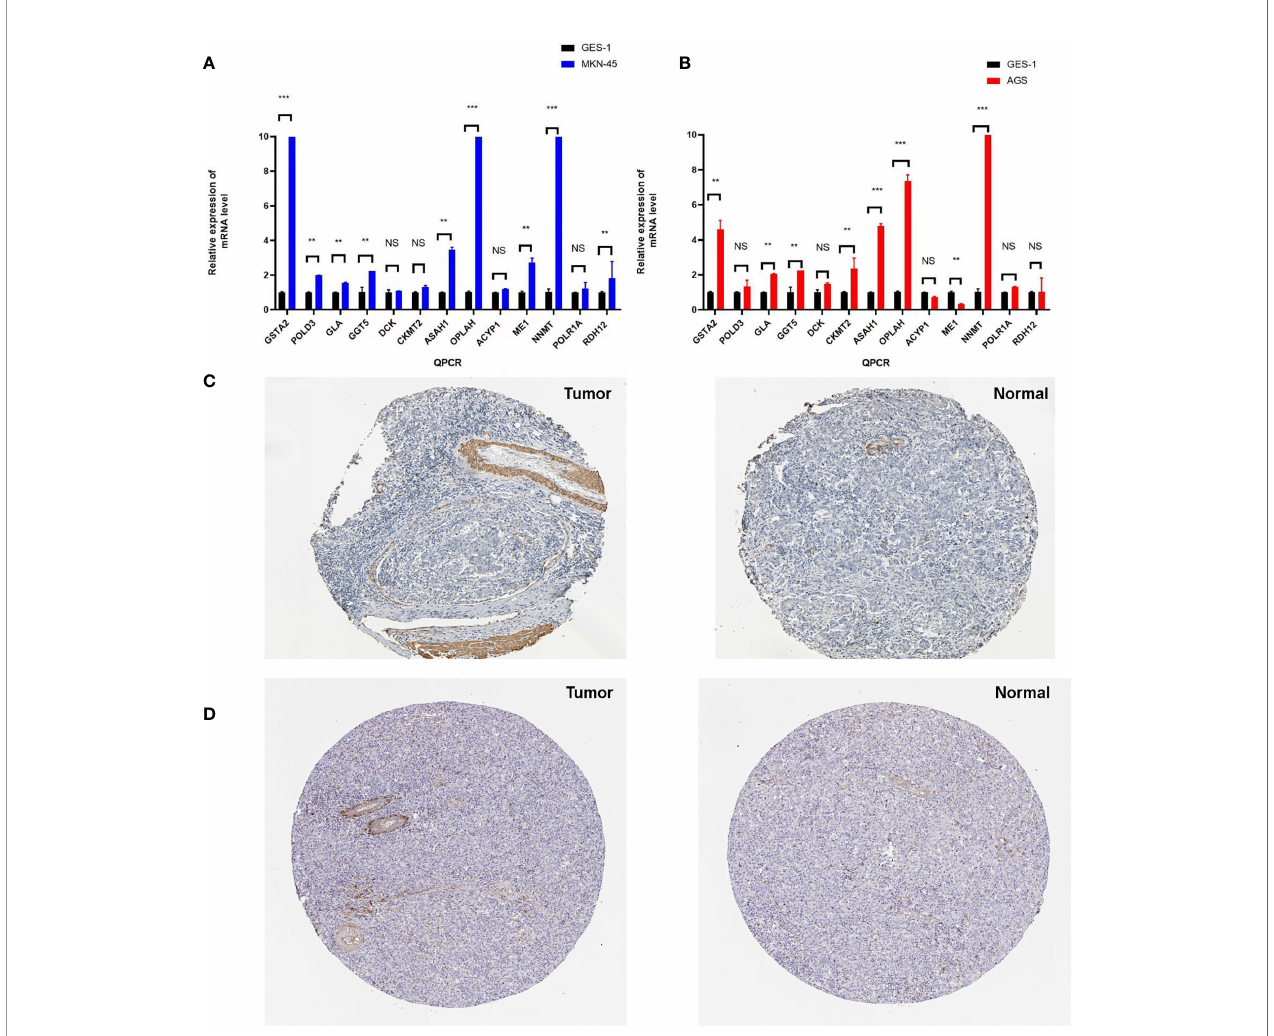
FIGURE 9 | The veri fi cation of identi fi ed genes using PCR and HPA database. (A) Q-PCR was used to validate the expressions of 13 metabolism-related genes (GSTA2, POLD3, GLA, GGT5, DCK, CKMT2, ASAH1, OPLAH, ME1, ACYP1, NNMT, POLR1A, and RDH12) between MKN-45 and GES-1. (B) Q-PCR was used to validate the expressions of 13 metabolism-related genes (GSTA2, POLD3, GLA, GGT5, DCK, CKMT2, ASAH1, OPLAH, ME1, ACYP1, NNMT, POLR1A, and RDH12) between AGS and GES-1. (C) Protein expression level of GSTA2 was veri fi ed in the Human Protein Atlas (HPA). (D) Protein expression level of ASAH1 was veri fi ed in the HPA. *p < 0.05, **p < 0.01, and ***p < 0.001. NS, None signi fi